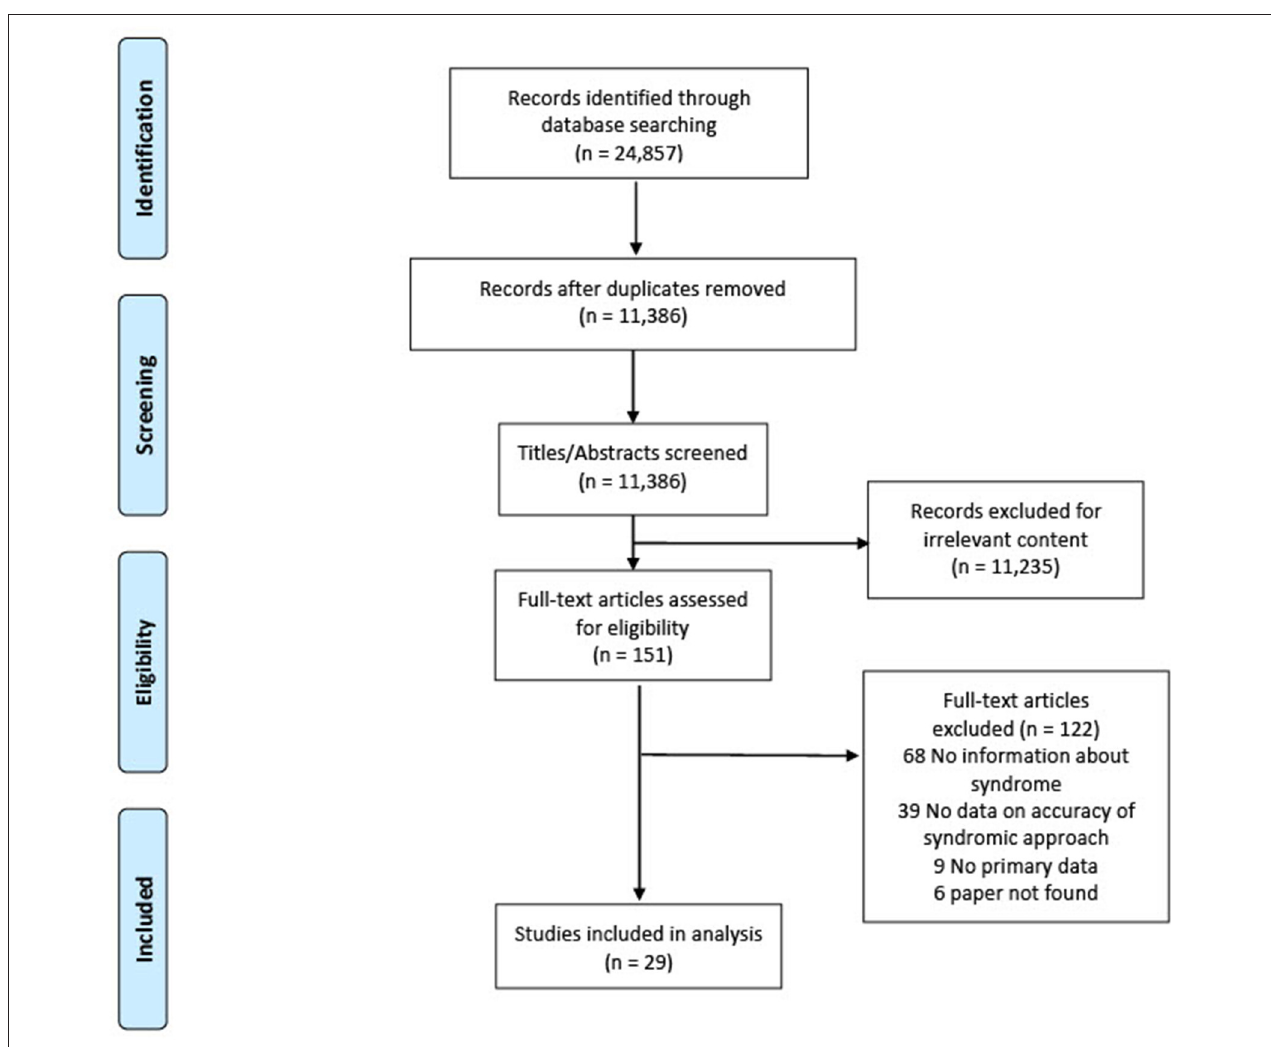
FIGURE 1 | PRISMA